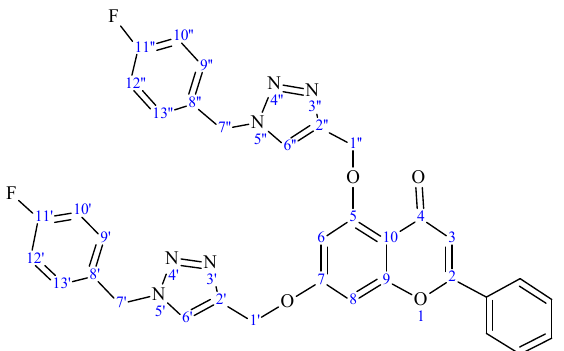
Figure 2. The skeleton numbering of compound 10 used for NMR assignment.